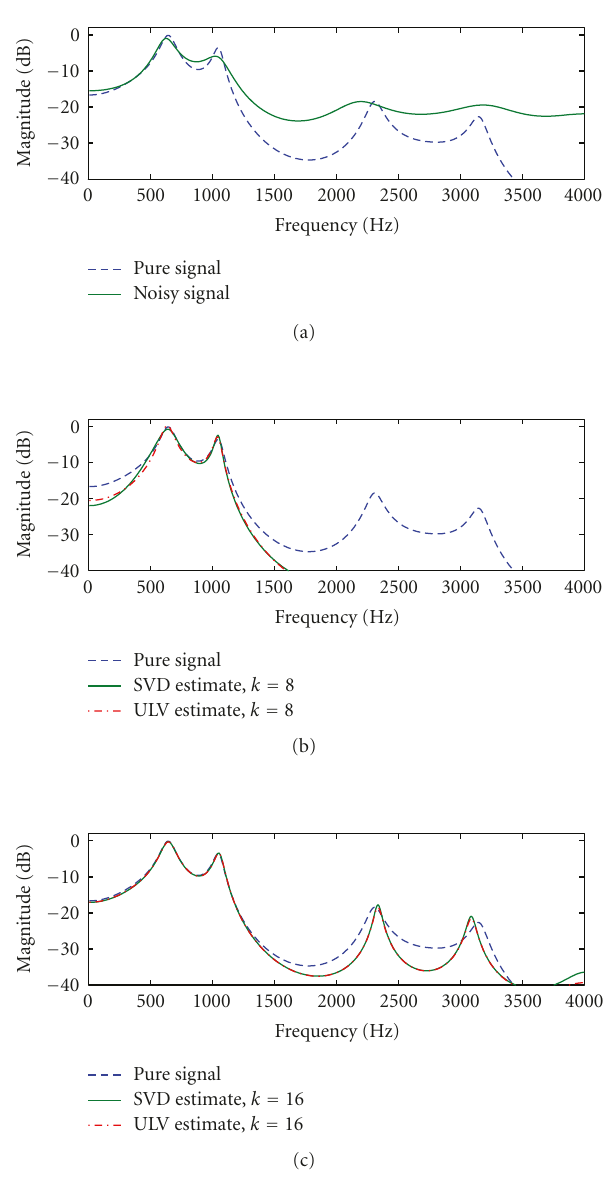
Figure 5: LPC spectra of the signals in the white noise example, us- ing SVD- and ULV-based MV estimates. (a) Clean and noisy signals; (b) and (c) estimates; both SNRs are 12.5 dB for k = 8 and 13.8 dB for k = 16.